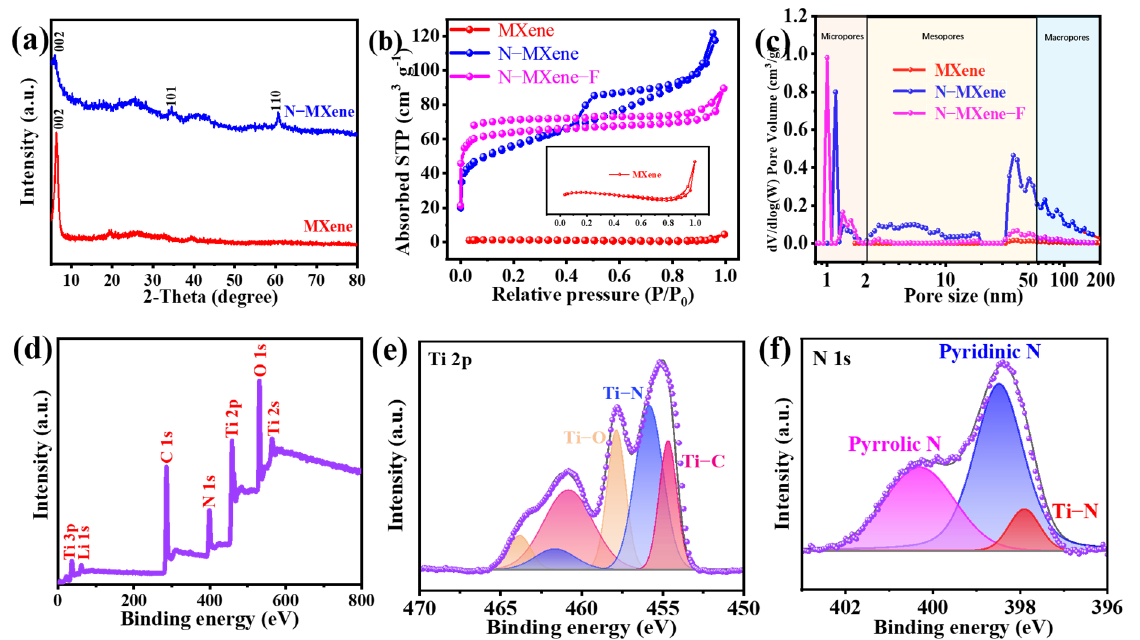
Figure 3. ( a ) XRD patterns of N-MXene and MXene; ( b ) nitrogen adsorption/desorption isotherms of MXene, N-MXene, and N-MXene-F; ( c ) pore size distribution of MXene, N-MXene, and N-MXene-F; ( d ) XPS survey scan; ( e ) Ti 2p; ( f ) N 1s spectra of N-MXene.